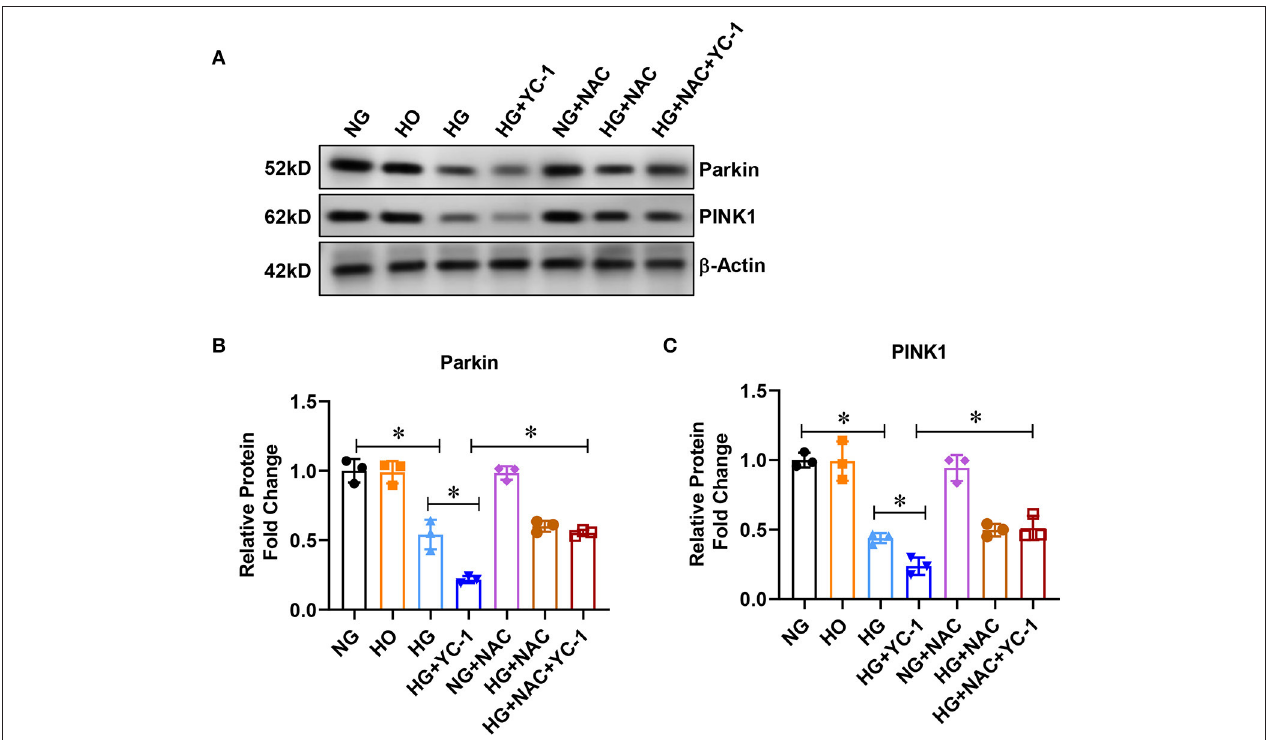
FIGURE 2 | HIF-1 α activated parkin/PINK1 pathway in HK-2cells subjected to HG exposure. (A–C) Expression of parkin and PINK1 was measured by Western blot in HK-2 cells treated with normal glucose (NG, 5.5mM D-glucose), high-glucose (HG, 30mM D-glucose) for 24h with or without 10 µ M HIF-1 α inhibitor YC- 1, and ROS scavenger NAC at a final concentration of 5mm.* p < 0.05. vs. indicated group. HIF-1 α , Hypoxia-Inducible Factor-1; Parkin PINK1, Parkin/PTEN Induced Putative Kinase1; YC-1, Lificiguat; ROS, Reactive Oxygen Species; NAC, N-Acetyl-L-Cysteine; HG, High